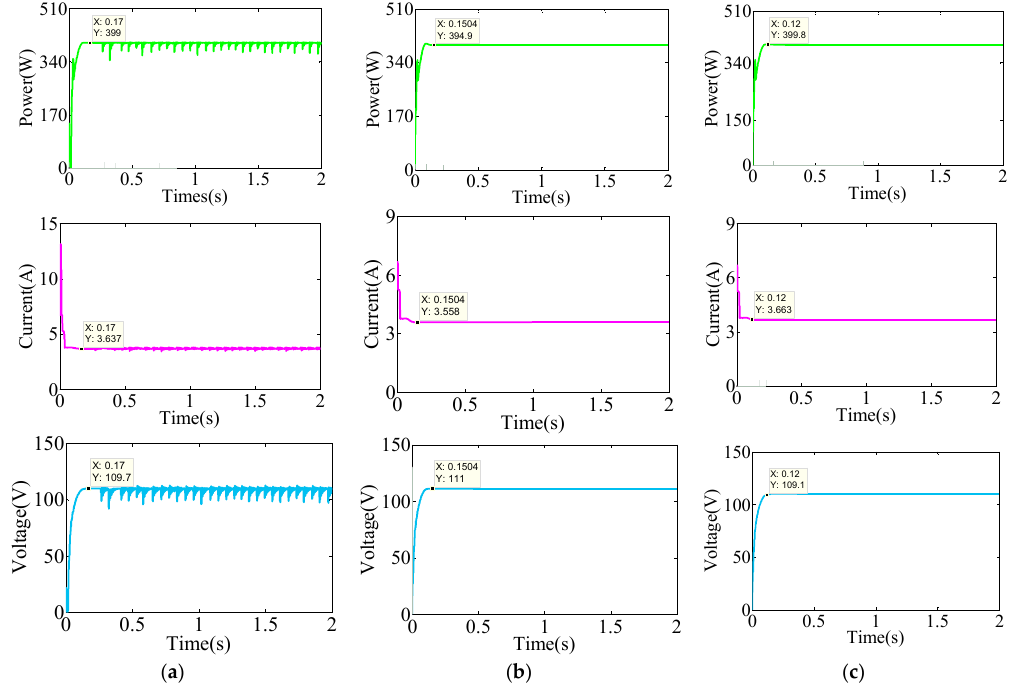
Figure 8. Power, current and voltage tracking curves of P&O, FPA and MFPA for weak shading ( a ) P&O; ( b ) FPA; ( c ) MFPA.